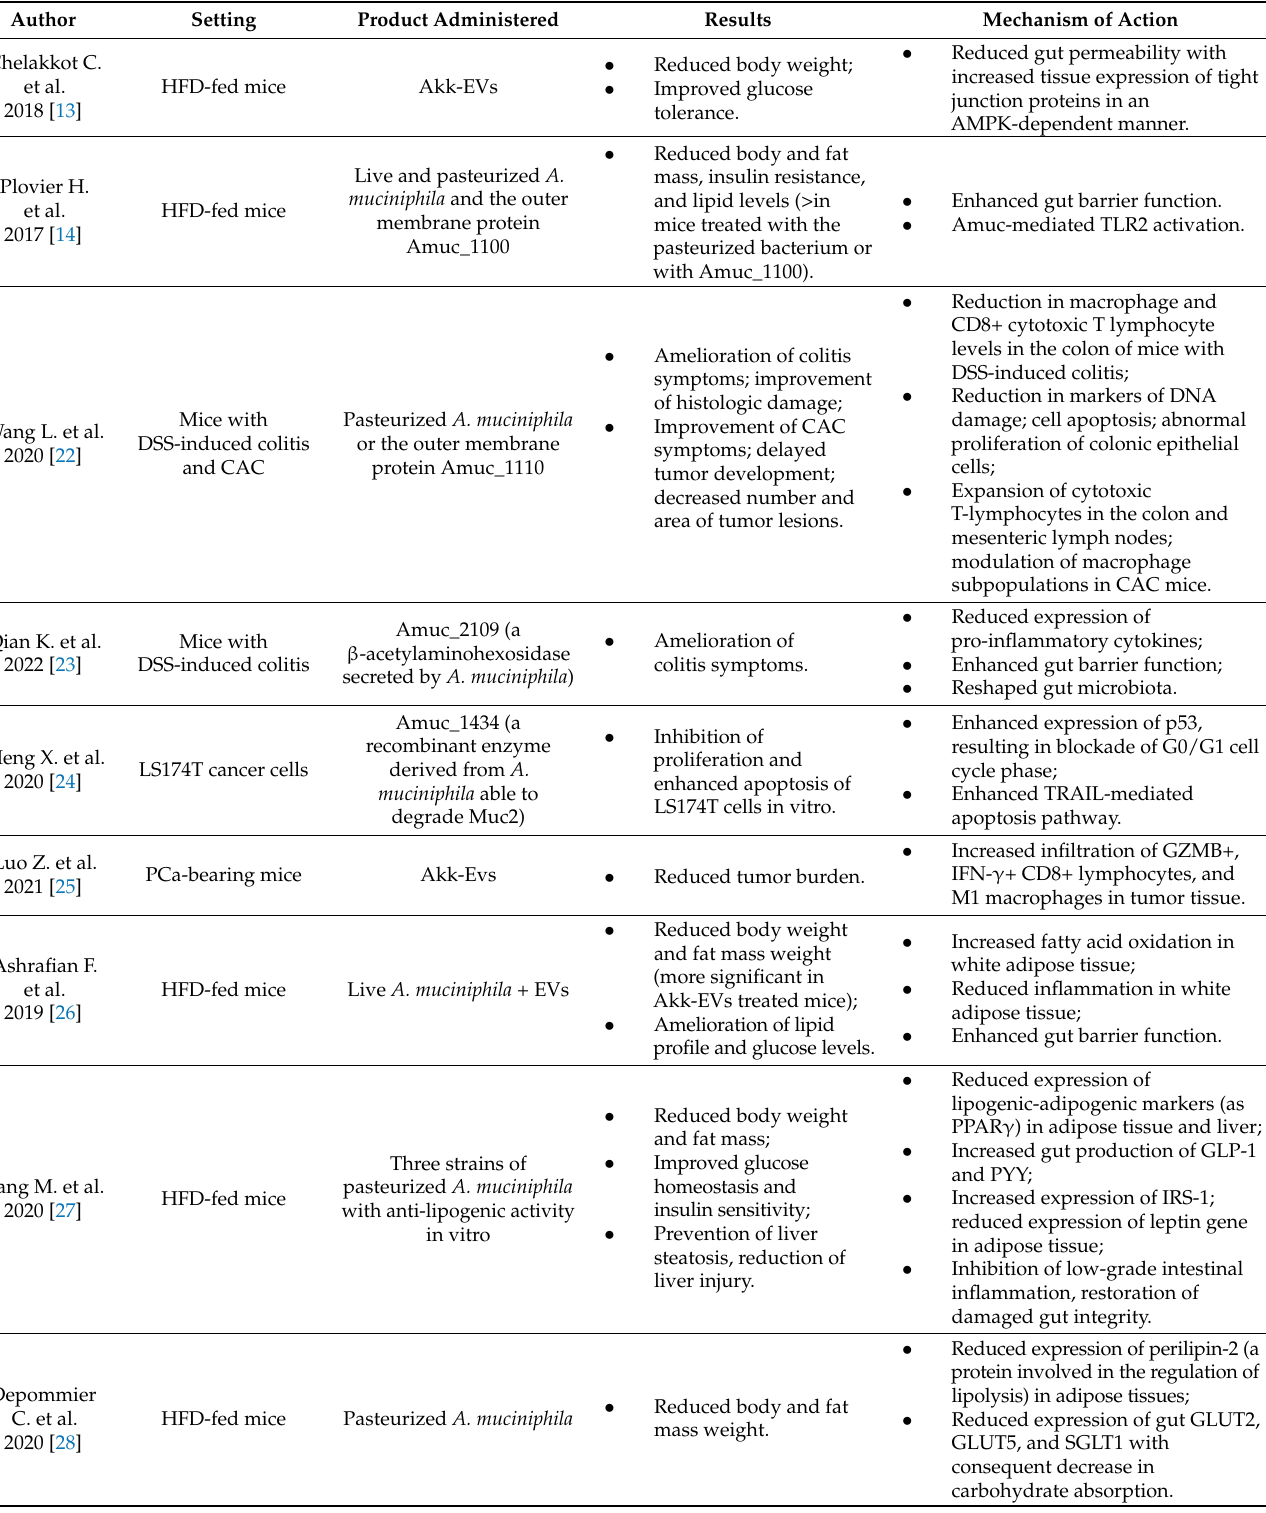
Table 1. Studies reporting on the beneficial effects of the administration of pasteurized A. muciniphila or its